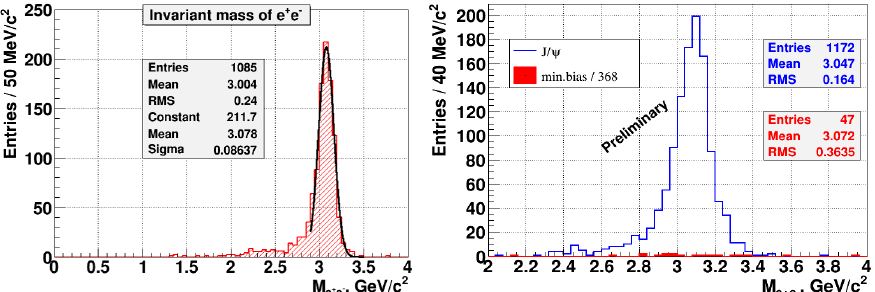
Figure 5. Left - reconstructed invariant mass of electron-positron pairs from J/ψ decays is quite high (~80% for |ψ decays (signal); right – the same and minimum bias events (background), remaining after applying selection cuts